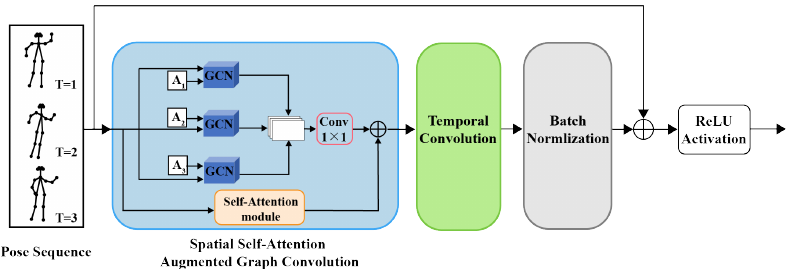
Figure 3. Spatial temporal self-attention augmented graph convolutional block. It is internally composed of a spatial self-attention augmented graph convolution (SAA-Graph, as shown in Figure 4) followed by a temporal convolution (TCN) [1] and batch normalization.